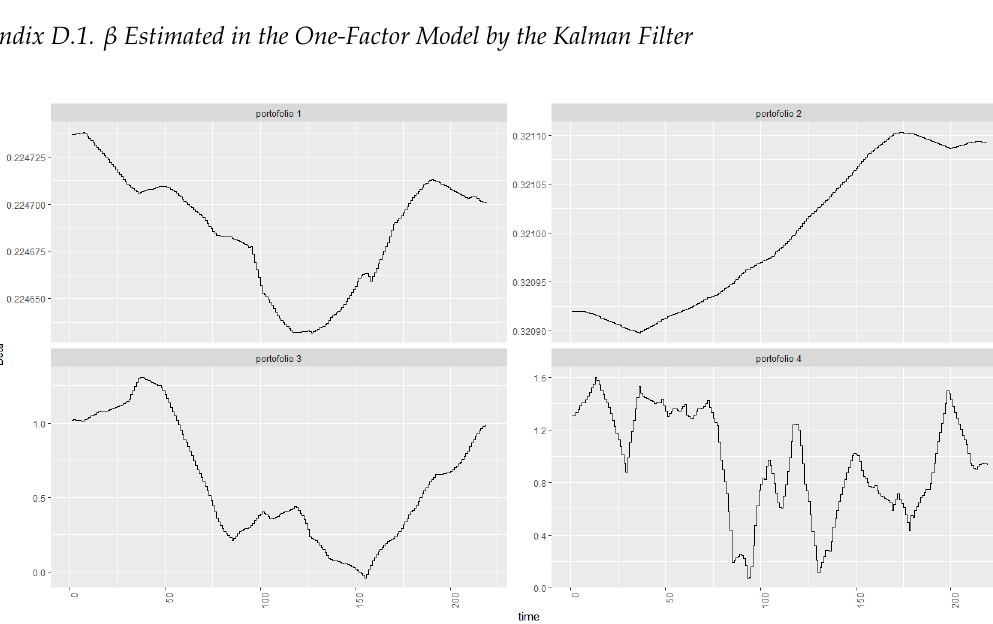
Figure A1. Beta estimated from the Kalman filter after the one-factor